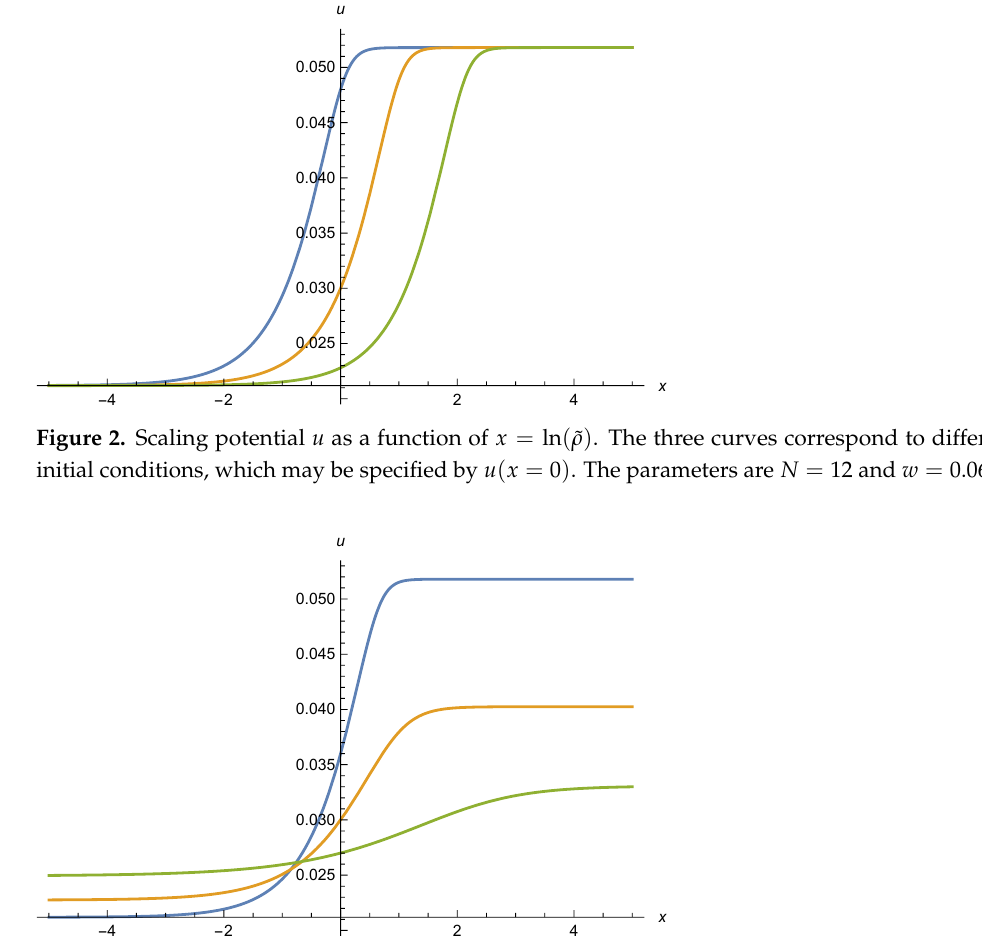
Figure 3. Scaling potential u as a function of x = ln ( ˜ ρ ) for different values of w = 0.06, w = 0.05, and w = 0.045 (upper, middle, and lower curve for large x , respectively). We use N =